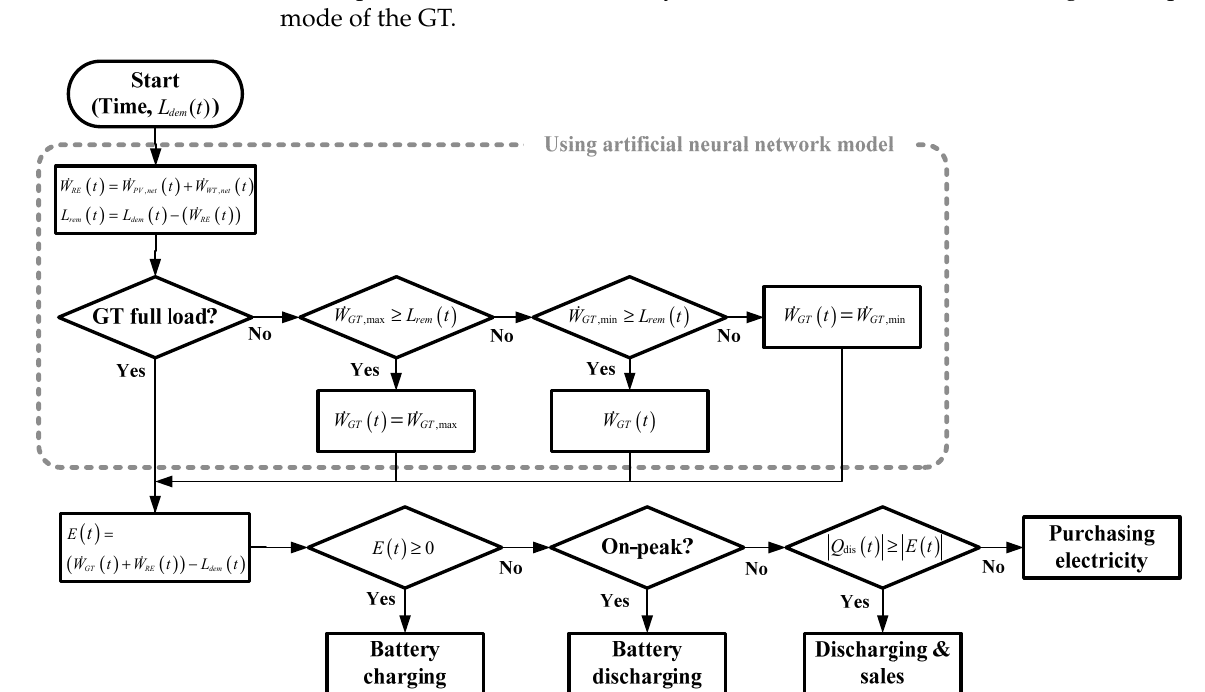
Figure 11. Operation strategy process for battery charge/discharge scheduling.